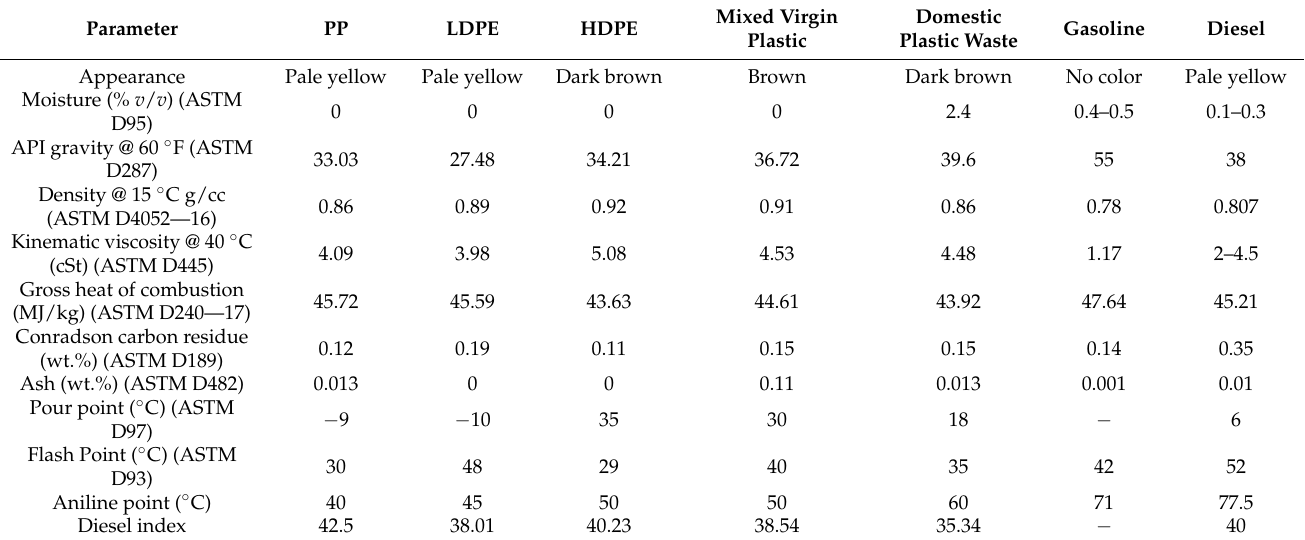
Table 4. Characteristics properties of alternate fuel obtained from different